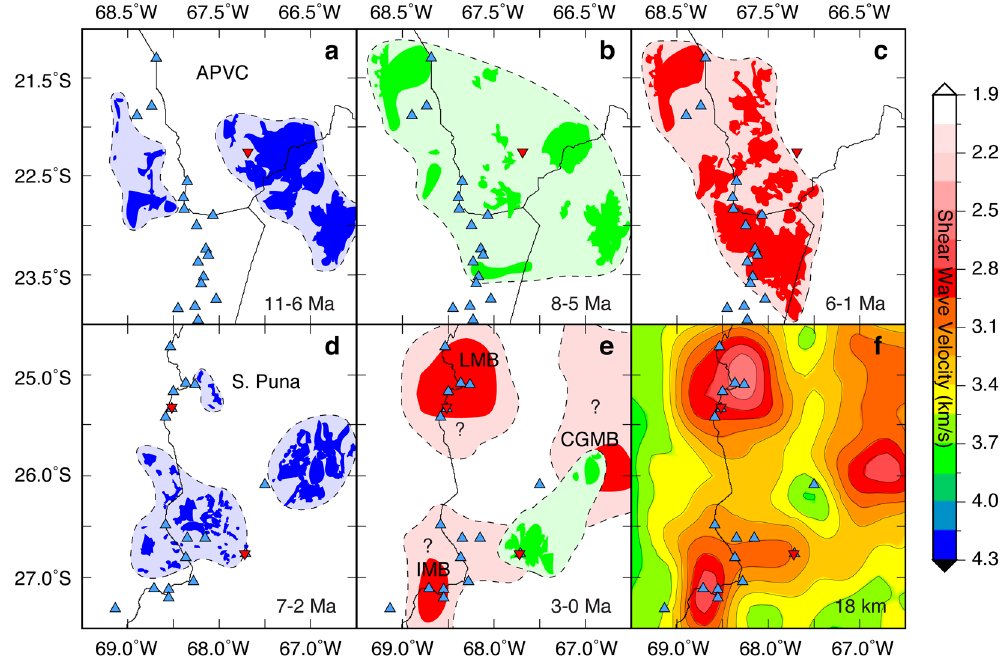
Figure 4. ( a–c ) The spatial-temporal evolution of ignimbrite emplacement (Freymuth et al . 11 and references therein) during the Altiplano-Puna Volcanic Complex (APVC) ignimbrite flare-up episode (11-1 Ma) with blue triangles showing Holocene age volcanism and inverted red triangles show INSAR measured vertical surface deformation centers 28 . Colors in each panel (blue, green, and red) represent the spatial distribution of ignimbrites erupted during that time period only, and appear to correlate with spatial configurations in the southern Puna. ( d–e ) The spatial-temporal evolution of ignimbrite emplacement for the southern Puna. Colors in each panel (blue and green) represent the spatial distribution of ignimbrites erupted during that time period only, and appear to correlate with spatial configurations in the APVC. Red contoured bodies represent the interpreted lateral extent of magma reservoirs inferred from the shear velocity model shown in panel ( f ). ( f ) Horizontal 18 km depth slice through our velocity model showing the lateral extent of interpreted magma reservoirs. The labels LMB (Lazufre Magma Body), CGMB (Cerro Galan Magma Body), and IMB (Incahuasi Magma Body) correspond to imaged magma reservoirs discussed in the text. These plots were made using the Generic Mapping Tool 61 , version 4.5.1